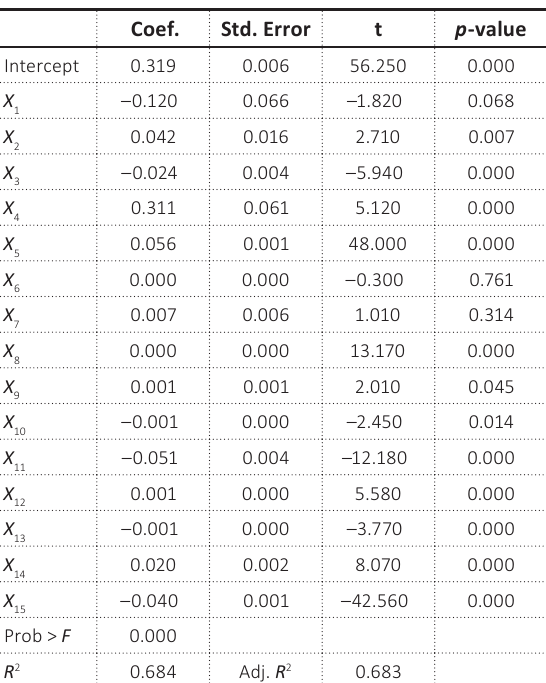
Table 5. Regression analysis of all selected financial ratios